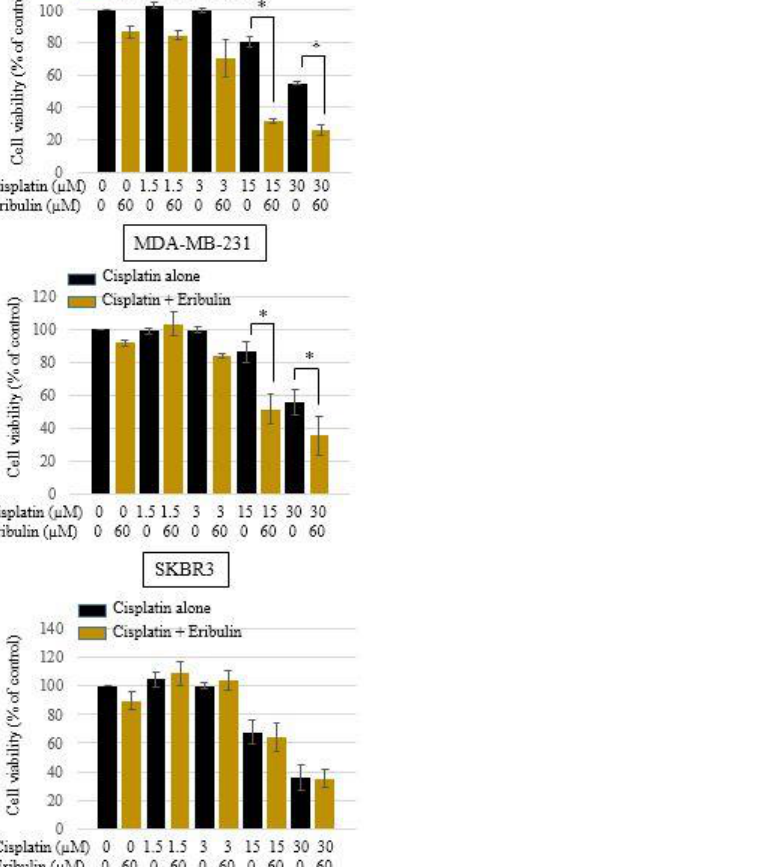
Table 1. Combination index (CI) values for cisplatin and eribulin combination for breast cancer cell lines.